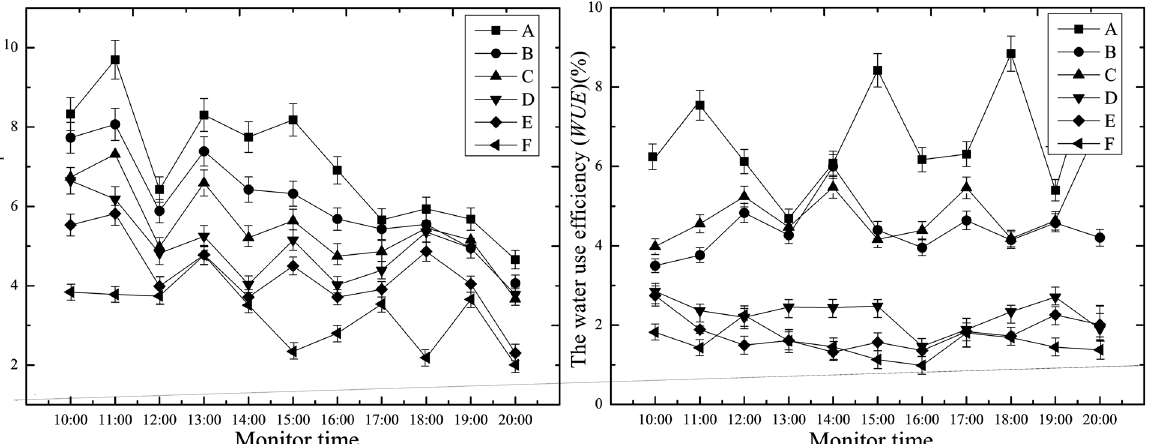
Fig 8. Effect of different salt dust treatments on the rate of transpiration ( T r ) of and efficiency of water use ( WUE ) by the cotton leaves.